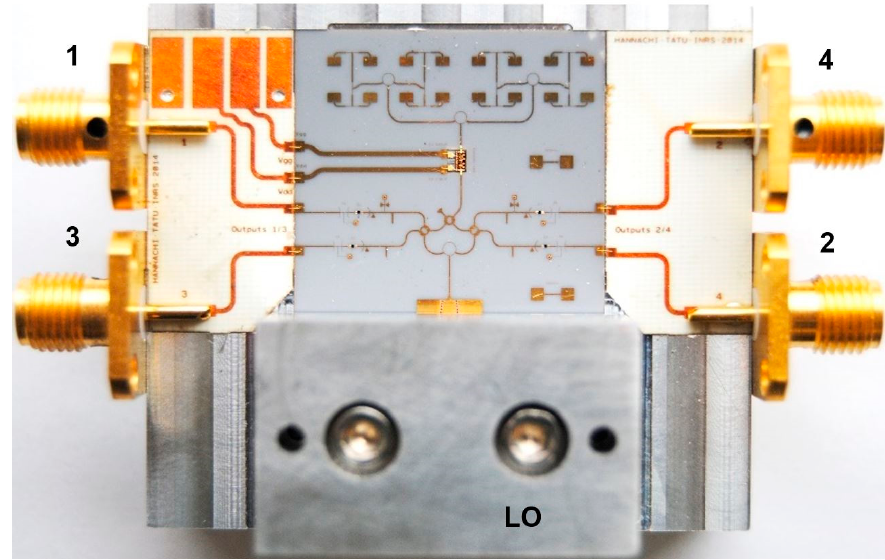
Figure 18. V-band front-end with monolithic microwave integrated circuits (MMIC) low-noise amplifier (LNA) mounted in a rectangular cut in the MHMIC die.